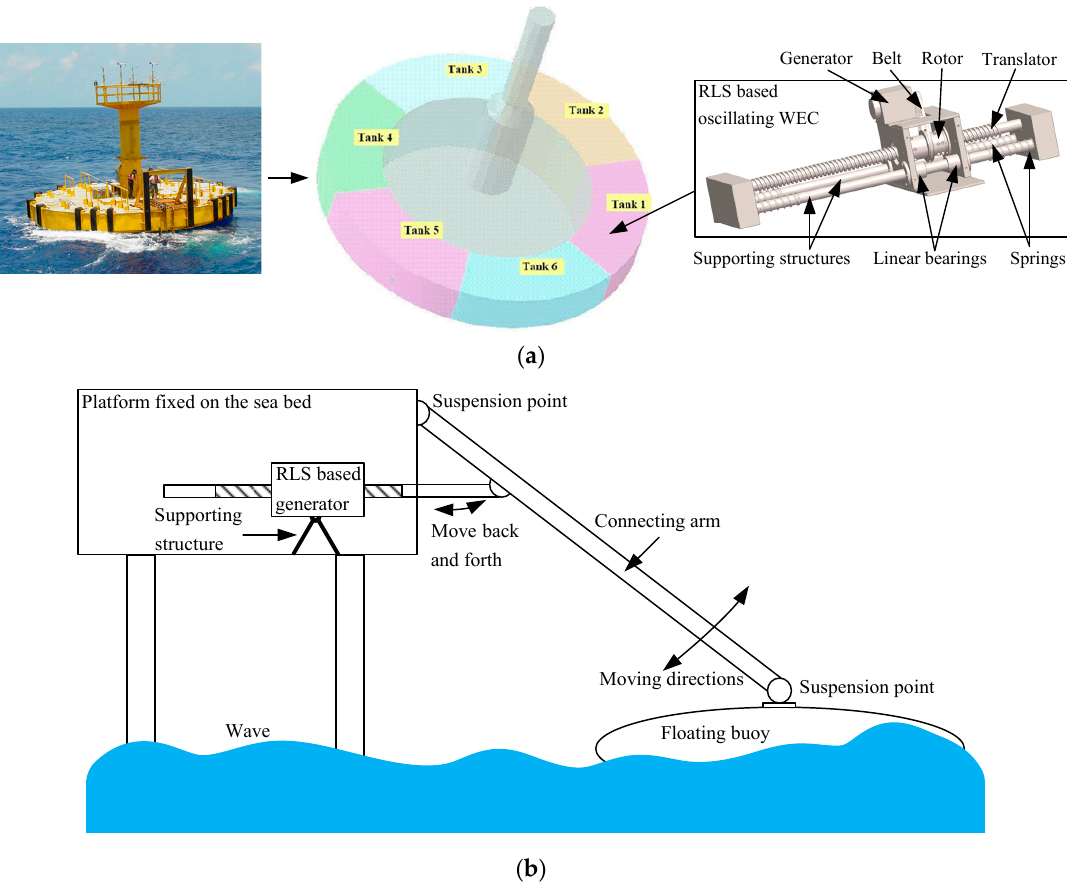
Figure 16. Two potential applications of RLS. ( a ) RLS-based oscillating wave energy converter (WEC). ( b ) RLS-based heaving buoy WEC.